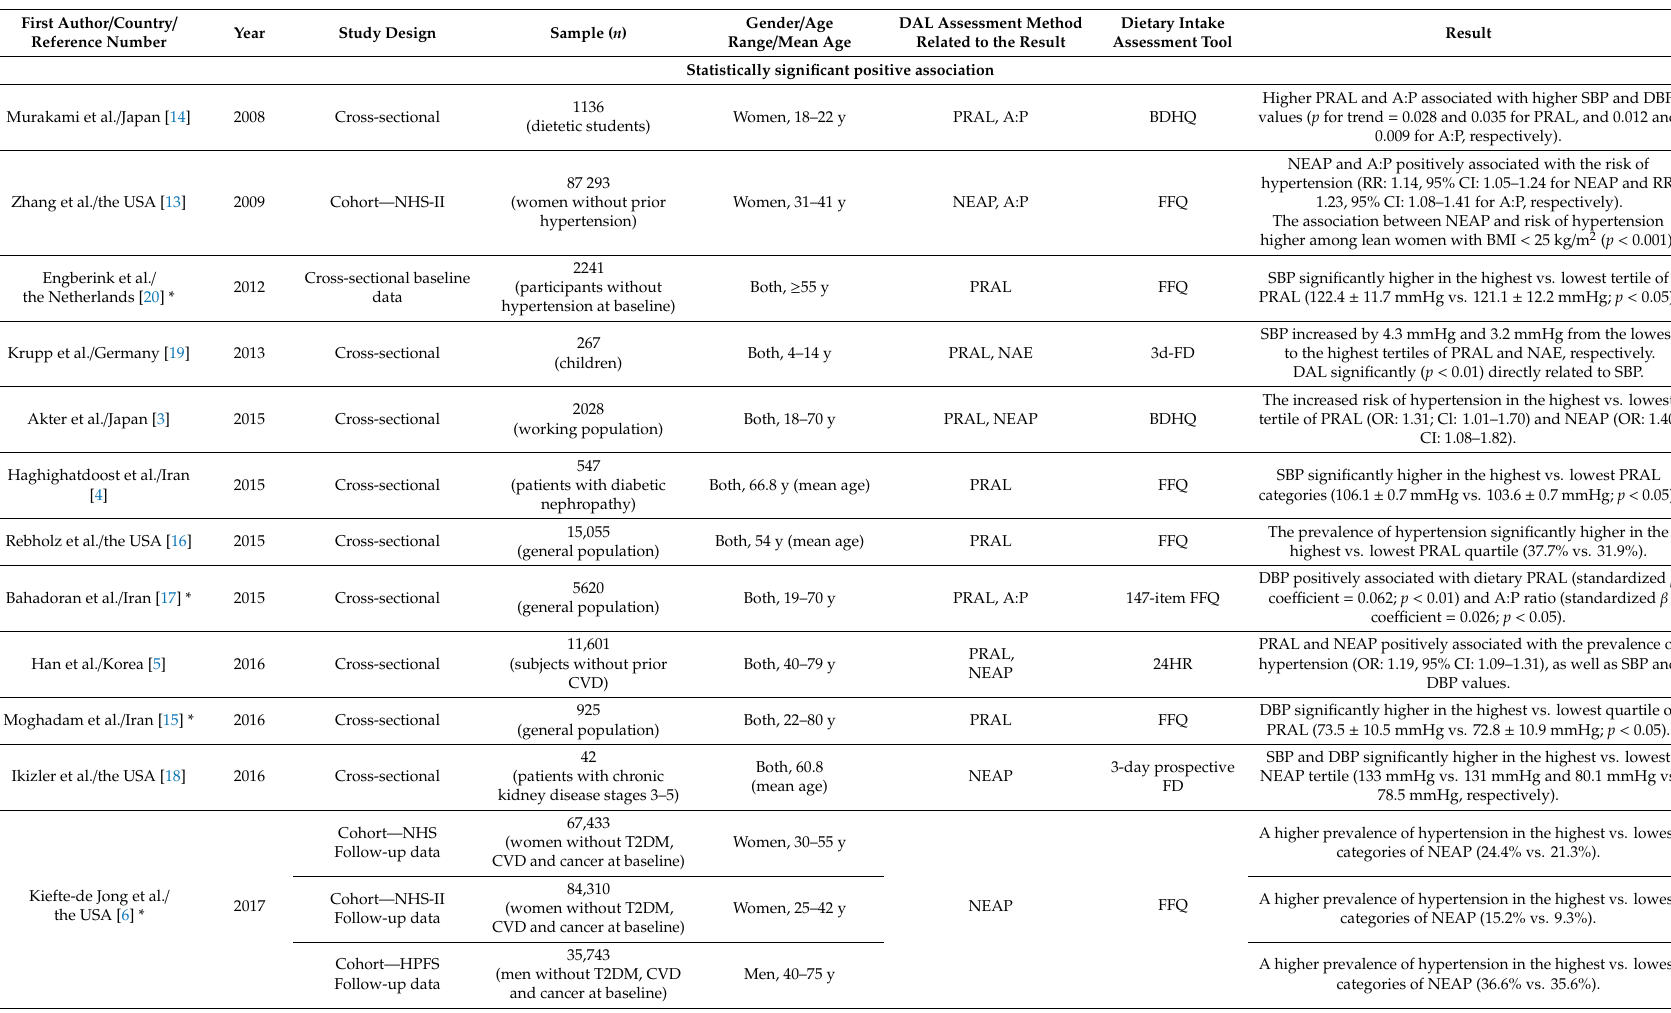
Table 1. Characteristics of studies referring to the association between DAL, systolic blood pressure (SBP), diastolic blood pressure (DBP) and the prevalence of